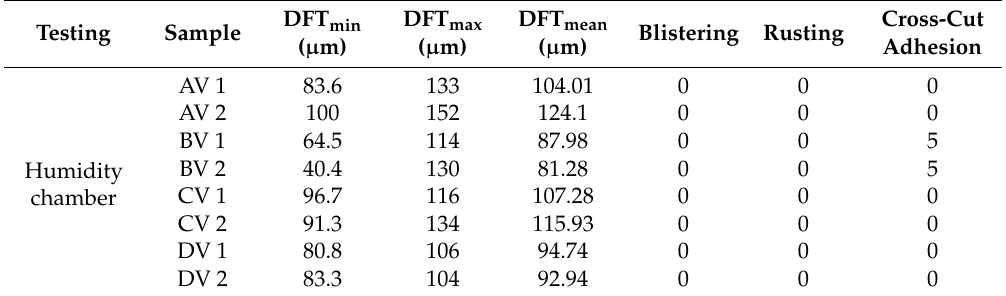
Table 2. Assessment of coating protection properties after 240 h in the humidity chamber.